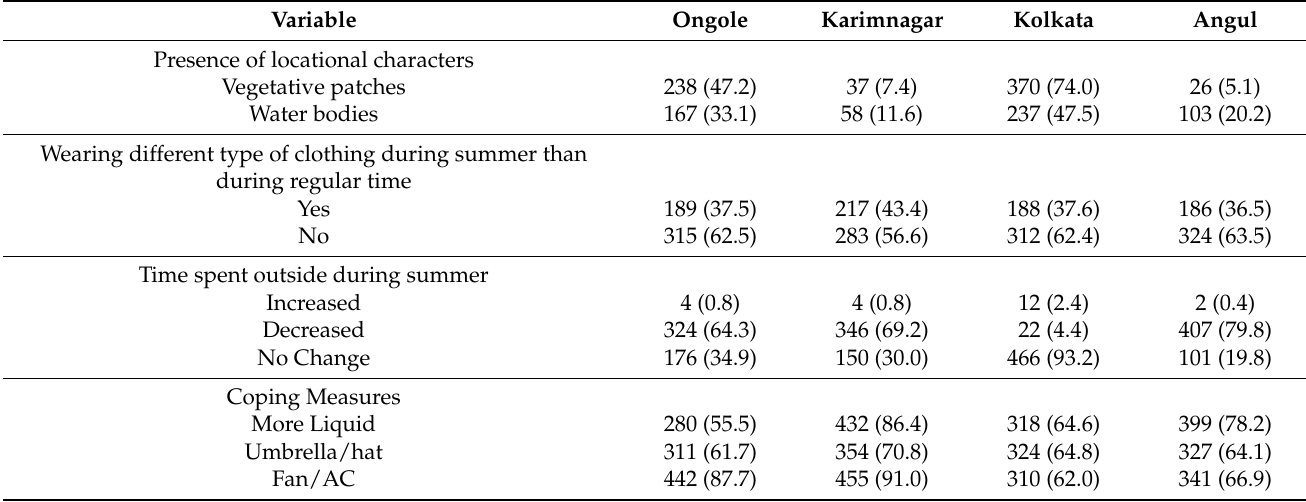
Table 5. Descriptive Statistics—Adaptive